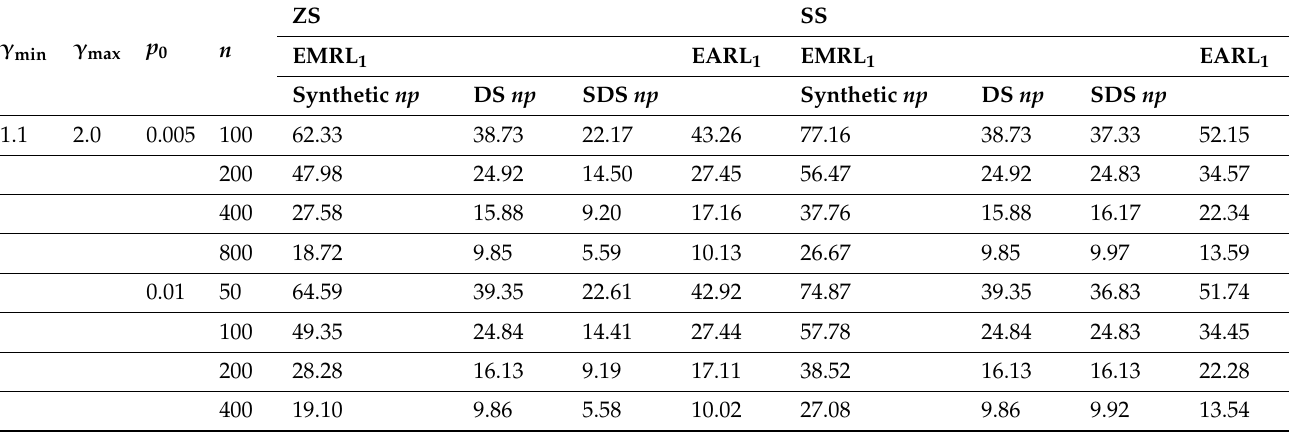
Table 5. EMRL 1 and EARL 1 comparisons between the SDS np , synthetic np and DS np charts, in both ZS and SS modes, when MRL 0min =